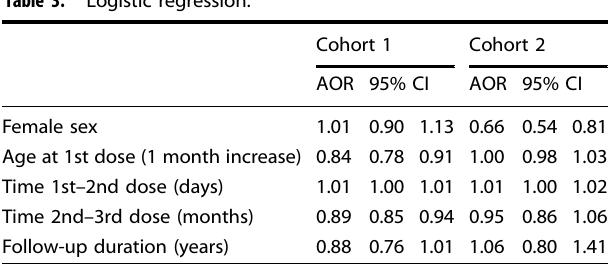
Table 3. Logistic regression.